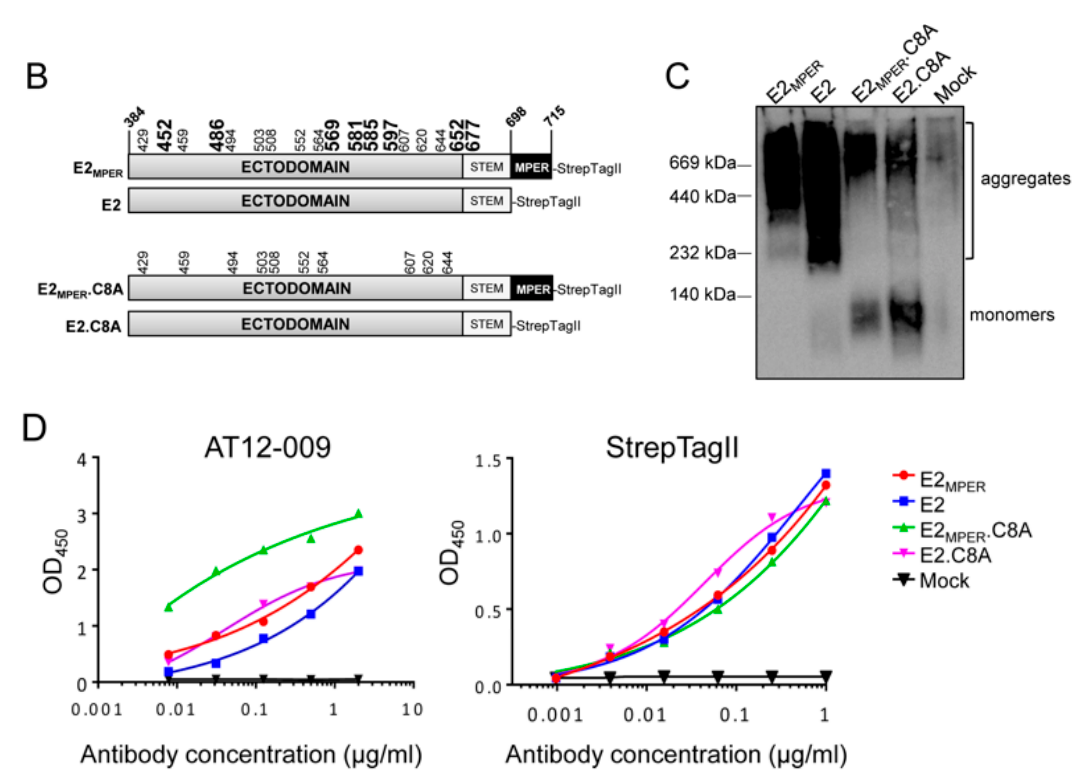
Figure 1. Design and characterization of recombinant E2 proteins. ( A ) Overview of the disulfide bond networks in the first two E2 core crystal structures [37,38]. Top: the cysteines in disulfide bonds (highlighted in yellow sticks) that were not ubiquitously assigned are indicated in italic bold.